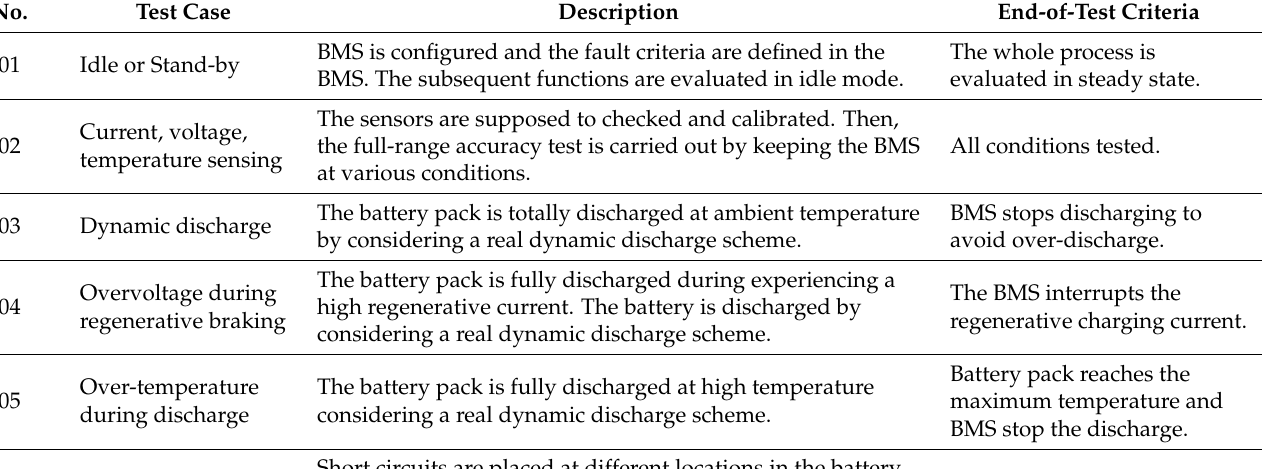
Table 2. BMS test